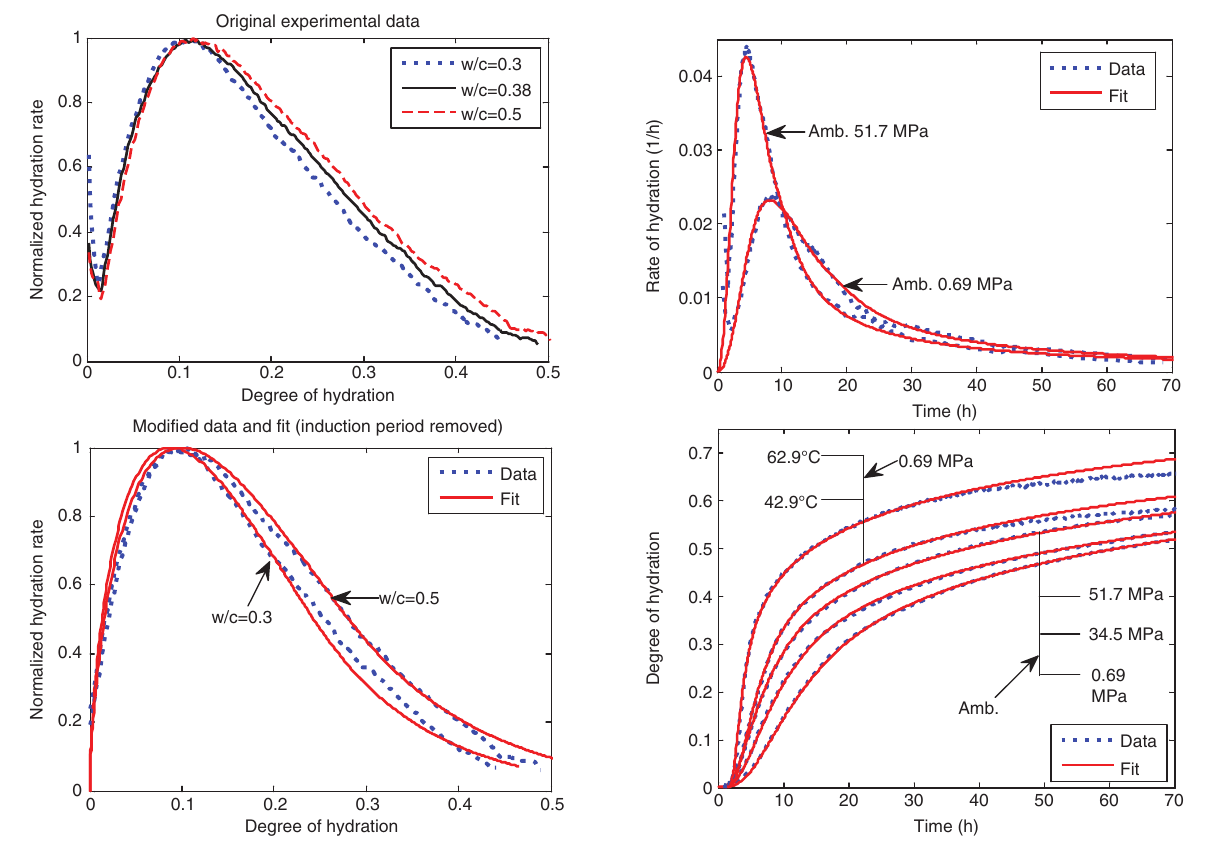
Figure 9: Model fit to experimental data of Class H-P cement cured at temperatures and pressures (w/c =